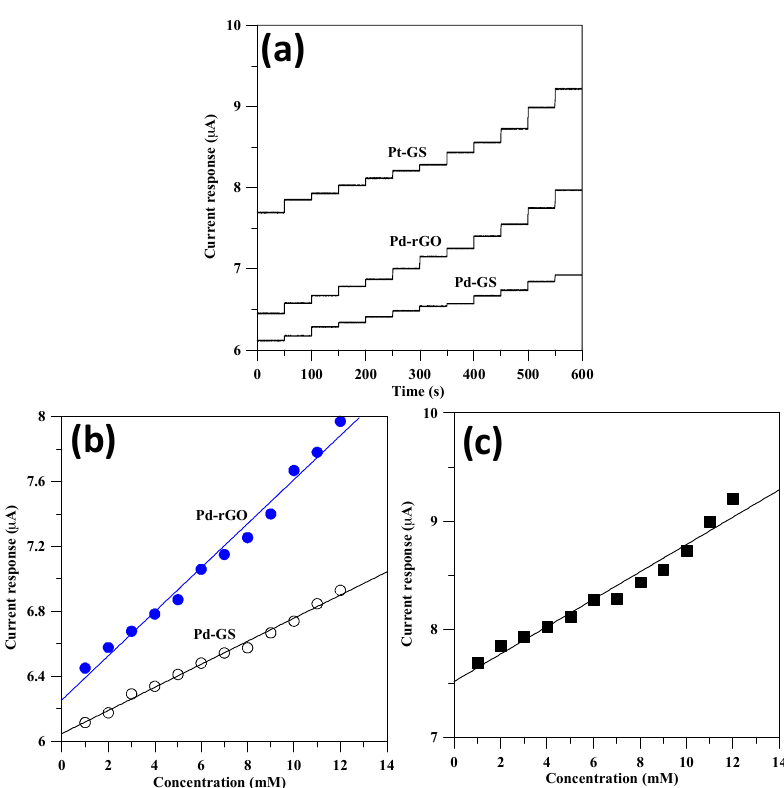
Figure 8. ( a ) Current response as a function of injection period of glucose under N2 atmosphere. Linear calibration curves of current response versus glucose concentration for ( b ) Pd-GS and Pd-rGO and ( c ) Pt-GS catalysts electrodes.